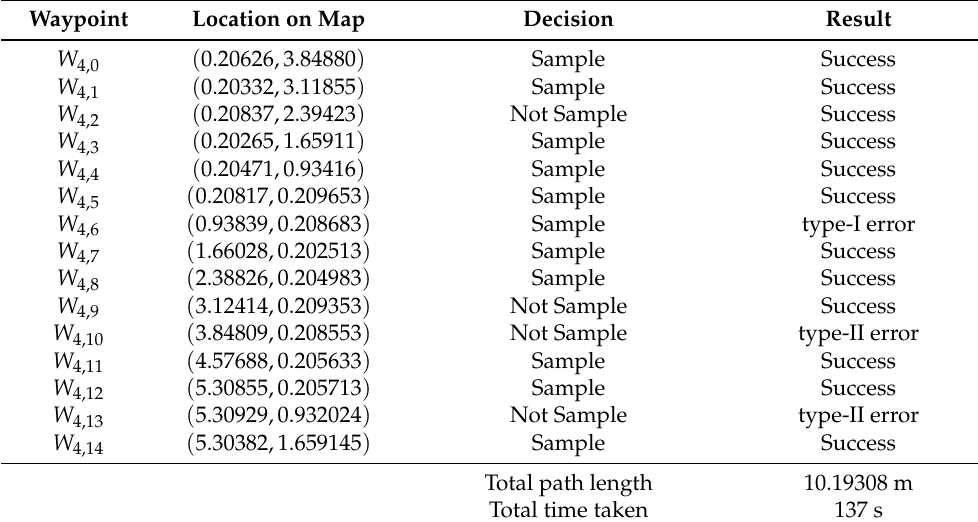
Table 6. The list of locations visited by the robot in trial-4 and sampling decision